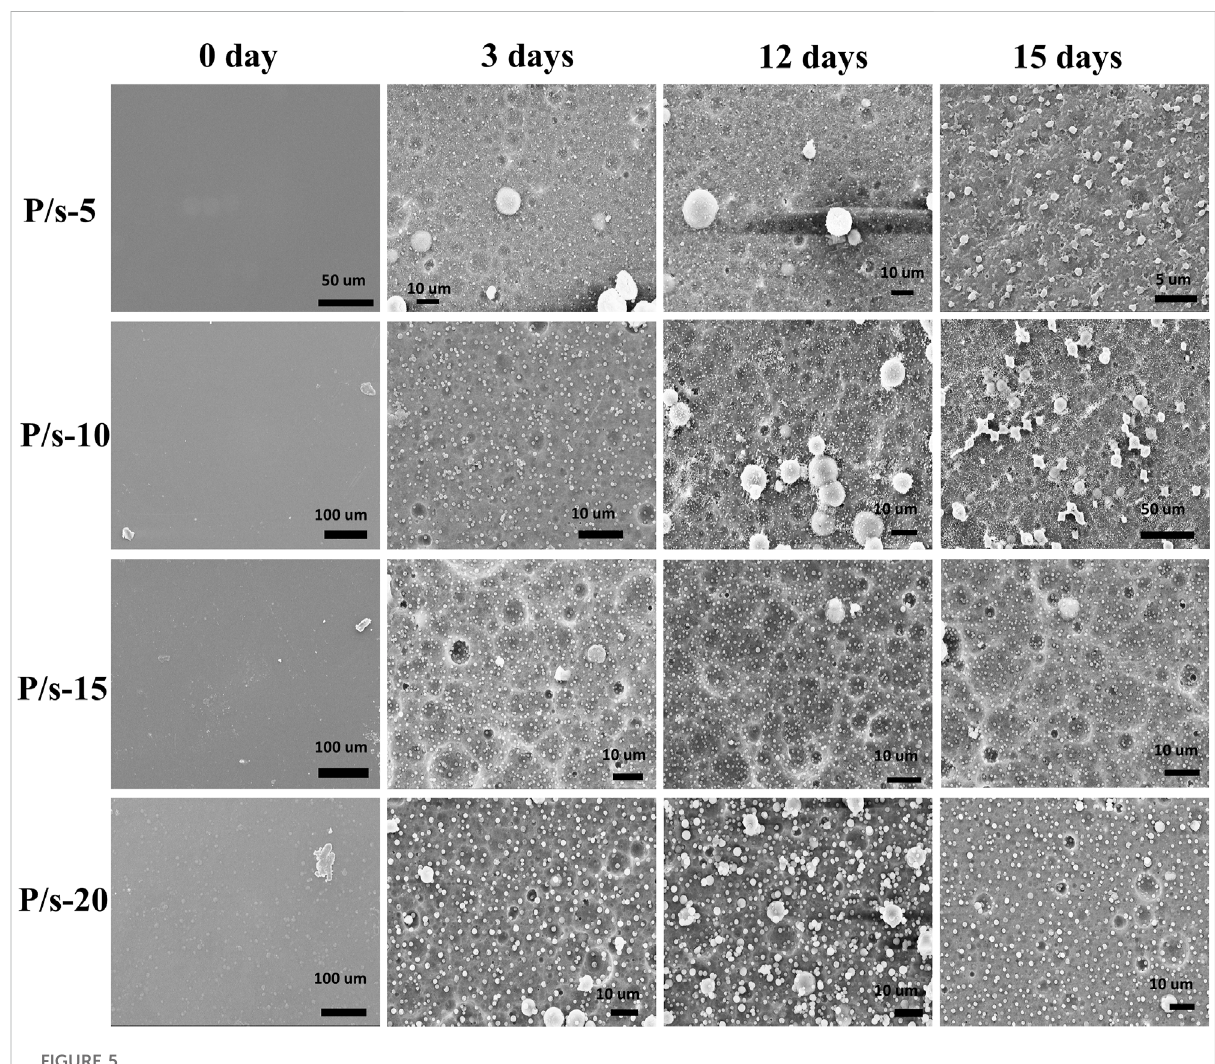
FIGURE 5 Surface morphology of the membranes during enzymatic degradation for 15